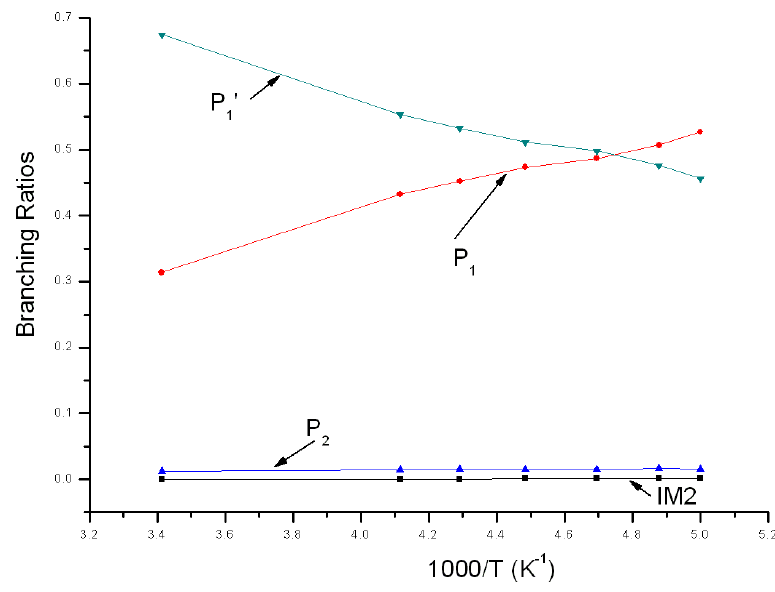
Figure 6. Branching ratios of various reaction channels at 760 Torr in a temperature range from 200 K to 293 K.